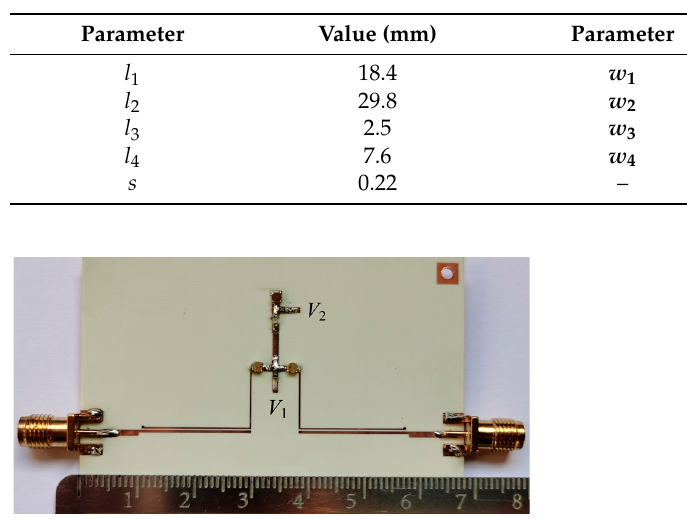
Table 2. Physical parameters of the proposed filter.